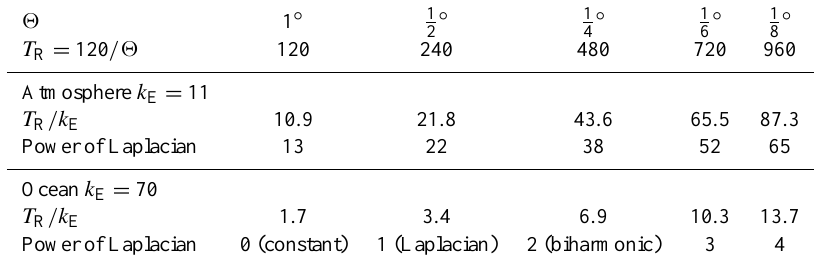
Table 1. Equivalent powers of the Laplacian for the subgrid net eddy viscosity of atmospheric and oceanic simulations at various angular grid spacings ( (cid:50) ). The equivalent truncation wavenumber is T R = 120 /(cid:50) . The energy-containing scale for the atmospheric and oceanic simulations are k E = 11 and k E = 70, respectively. The drain profiles ( ν d (n) ) are calculated from T R /k E using Eq. (15) and the scaling laws in Fig. 4, and likewise for the backscatter ( ν b (n) ), with the net ν net (n) = ν d (n) + ν b (n) . The spectral slope of ν net (n) is determined, divided by 2, and rounded to the nearest integer to approximate the effective power of the Laplacian